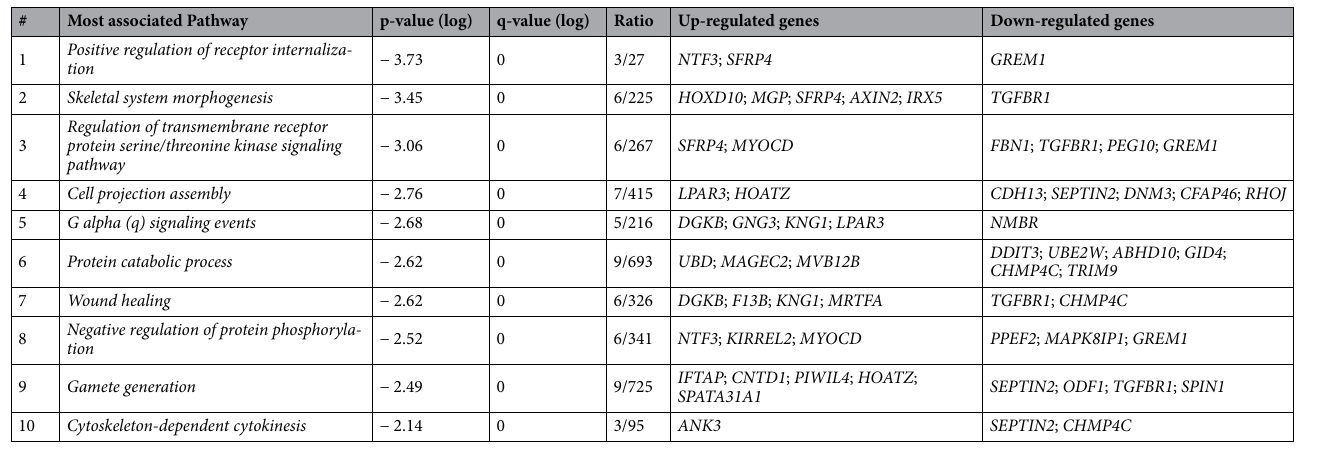
Table 4. Detailed classification of the top 10 enriched pathways most affected by MVPA levels, with p-value, q-value (multi-test adjusted p-value), ratio and up- and down-regulated genes, according with Meta Scape